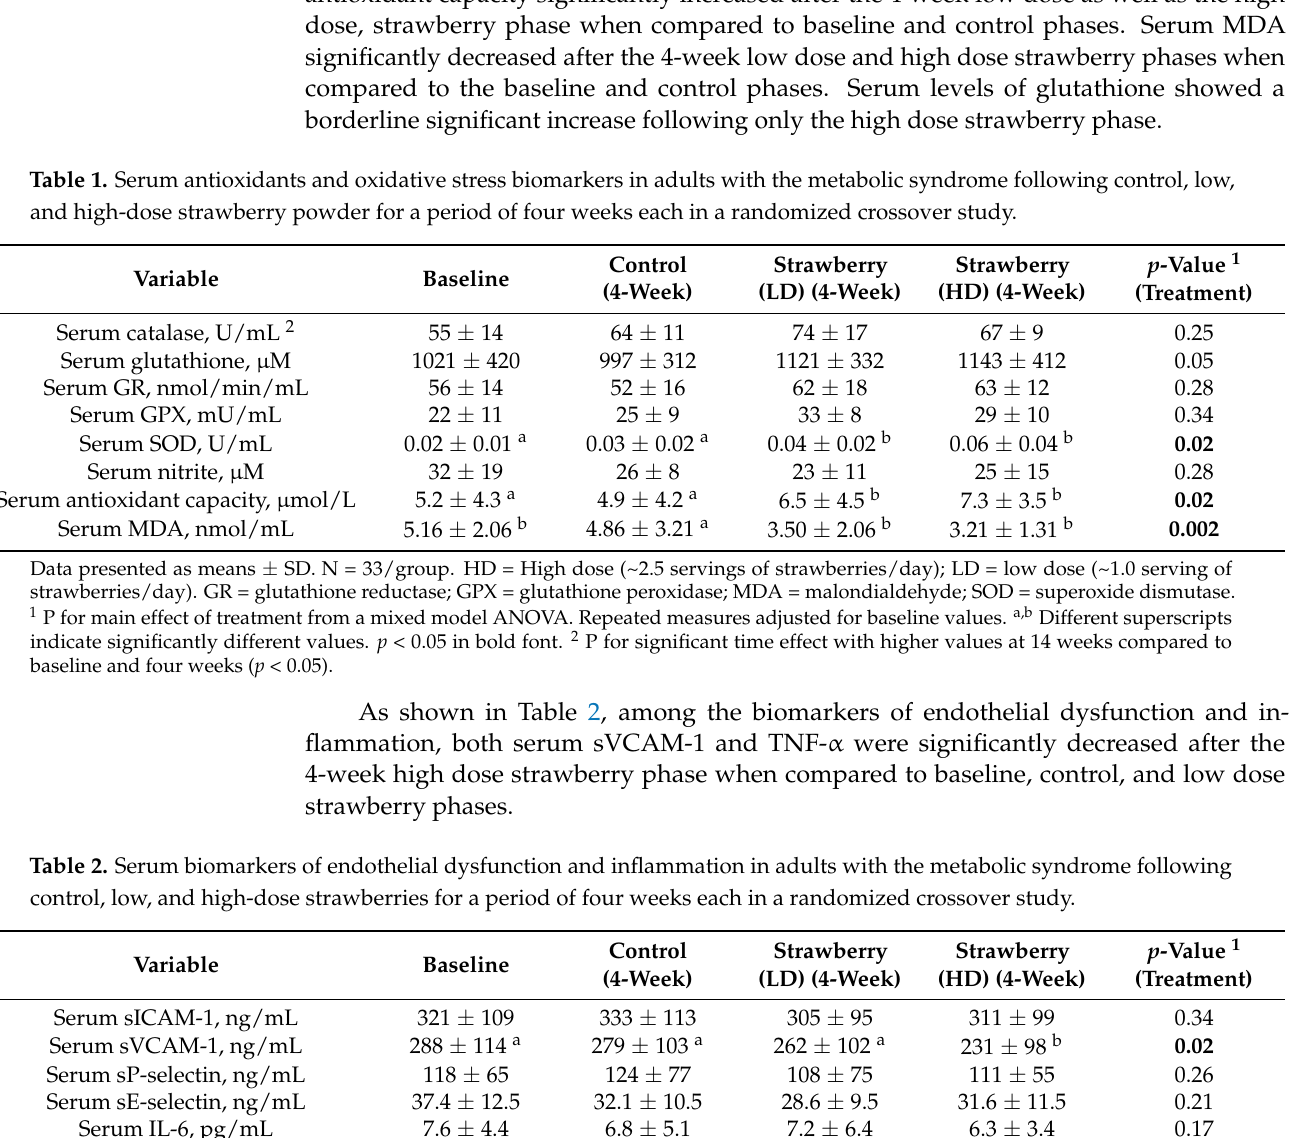
Serum sE-selectin,